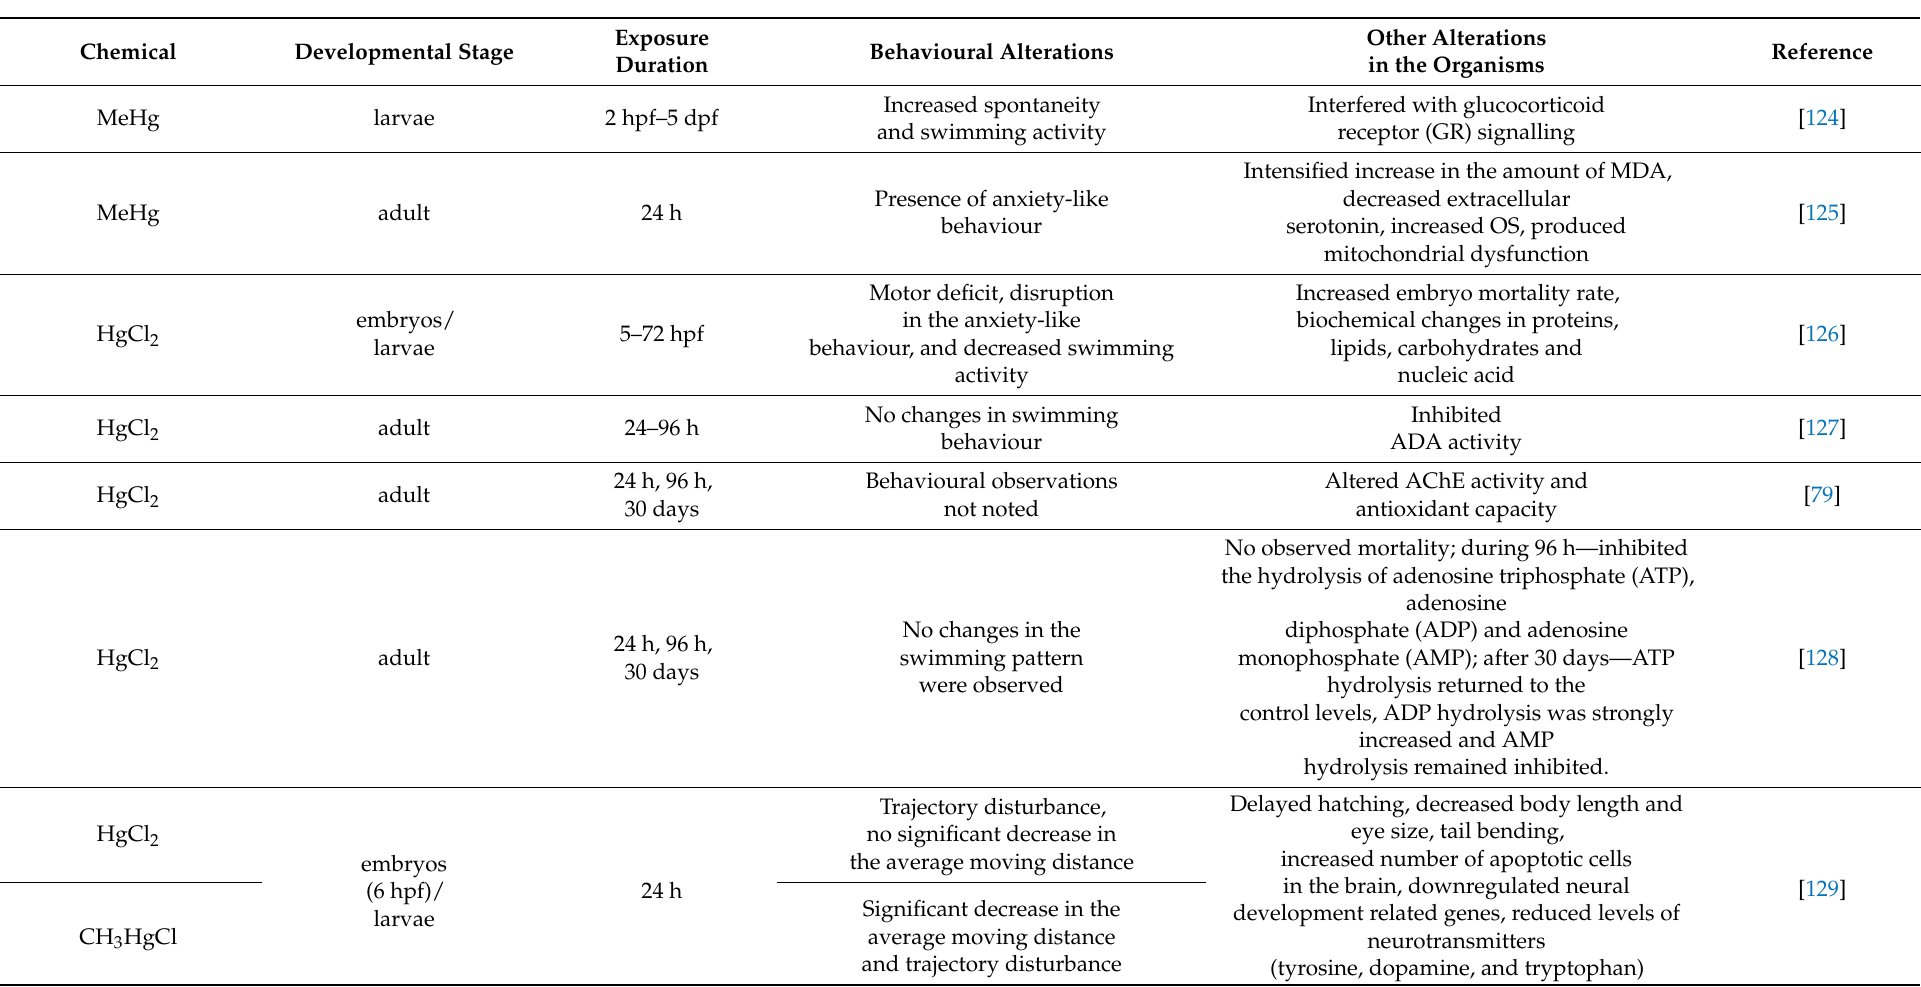
Table 2. Summary of zebrafish studies measuring behavioural, toxicological, and neurological effects of Cd, Hg, and Pb